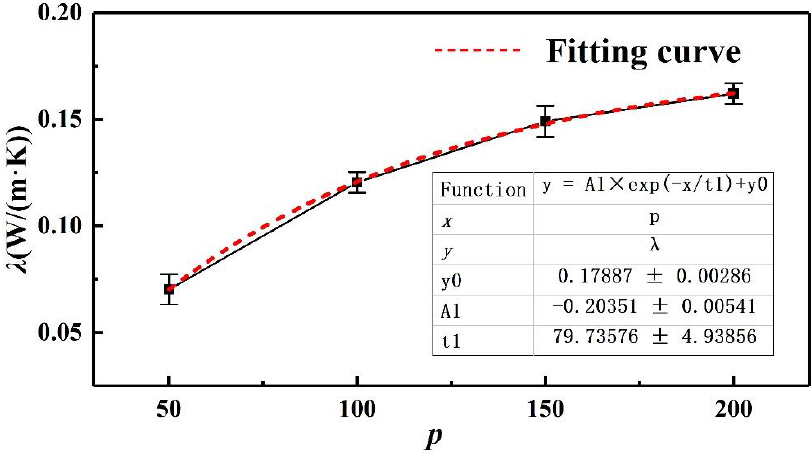
Figure 7. The change of PI thermal conductivity with the degree of polymerization.